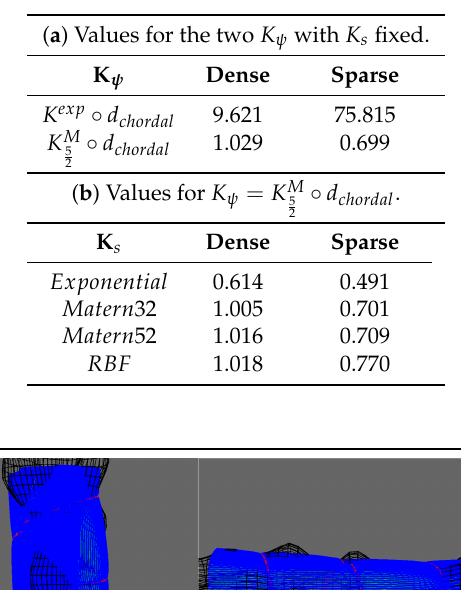
Table 2. Lengthscale l ψ values in different configurations.